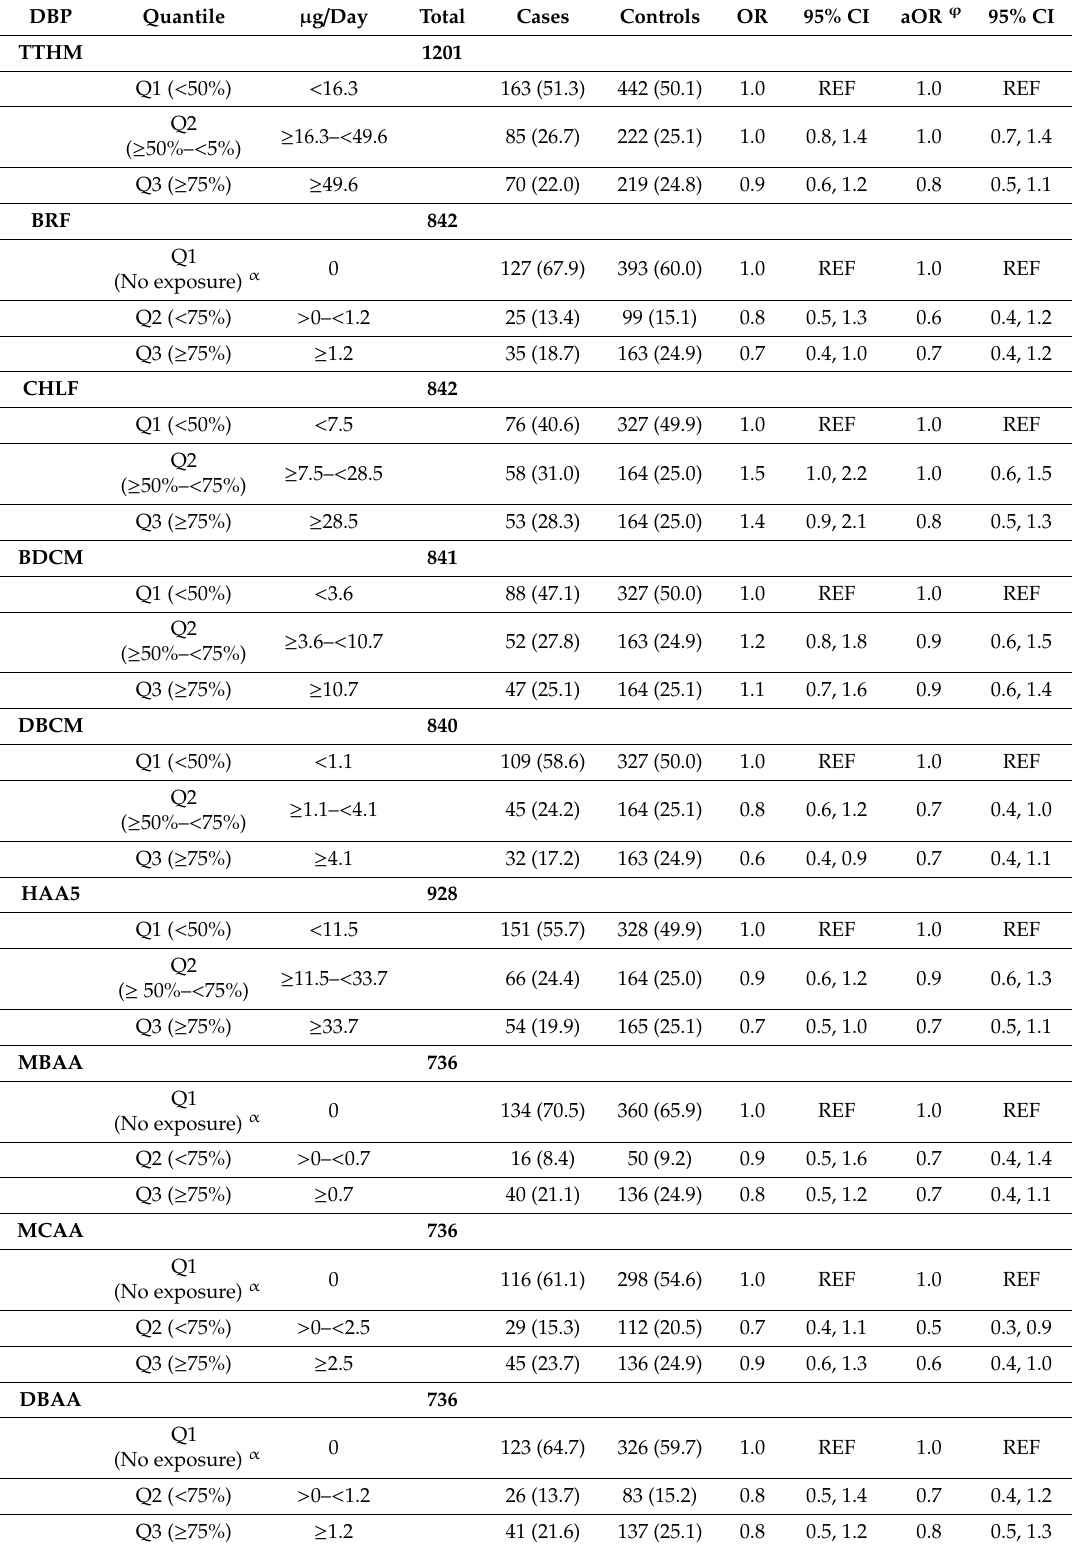
Table 4. Association between maternal ingestion of disinfection by-products (DBPs) and hypospadias, National Birth Defects Prevention Study, 2000–2005 ( n = 1213)